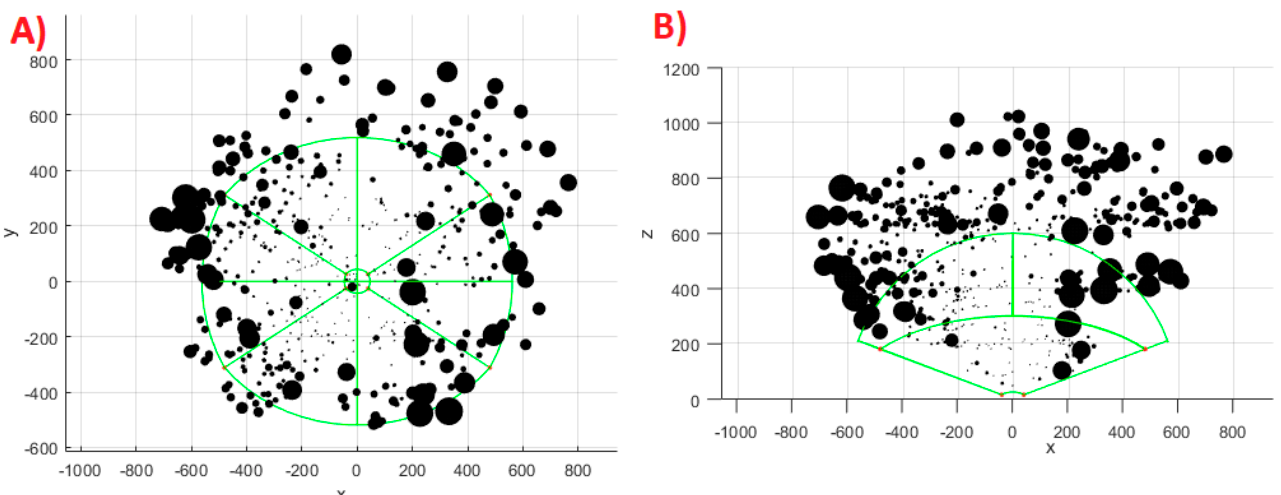
Figure 14. All measurements: ( A ) (top–bottom view), ( B ) (front view). X , y , and z axis are in mm.